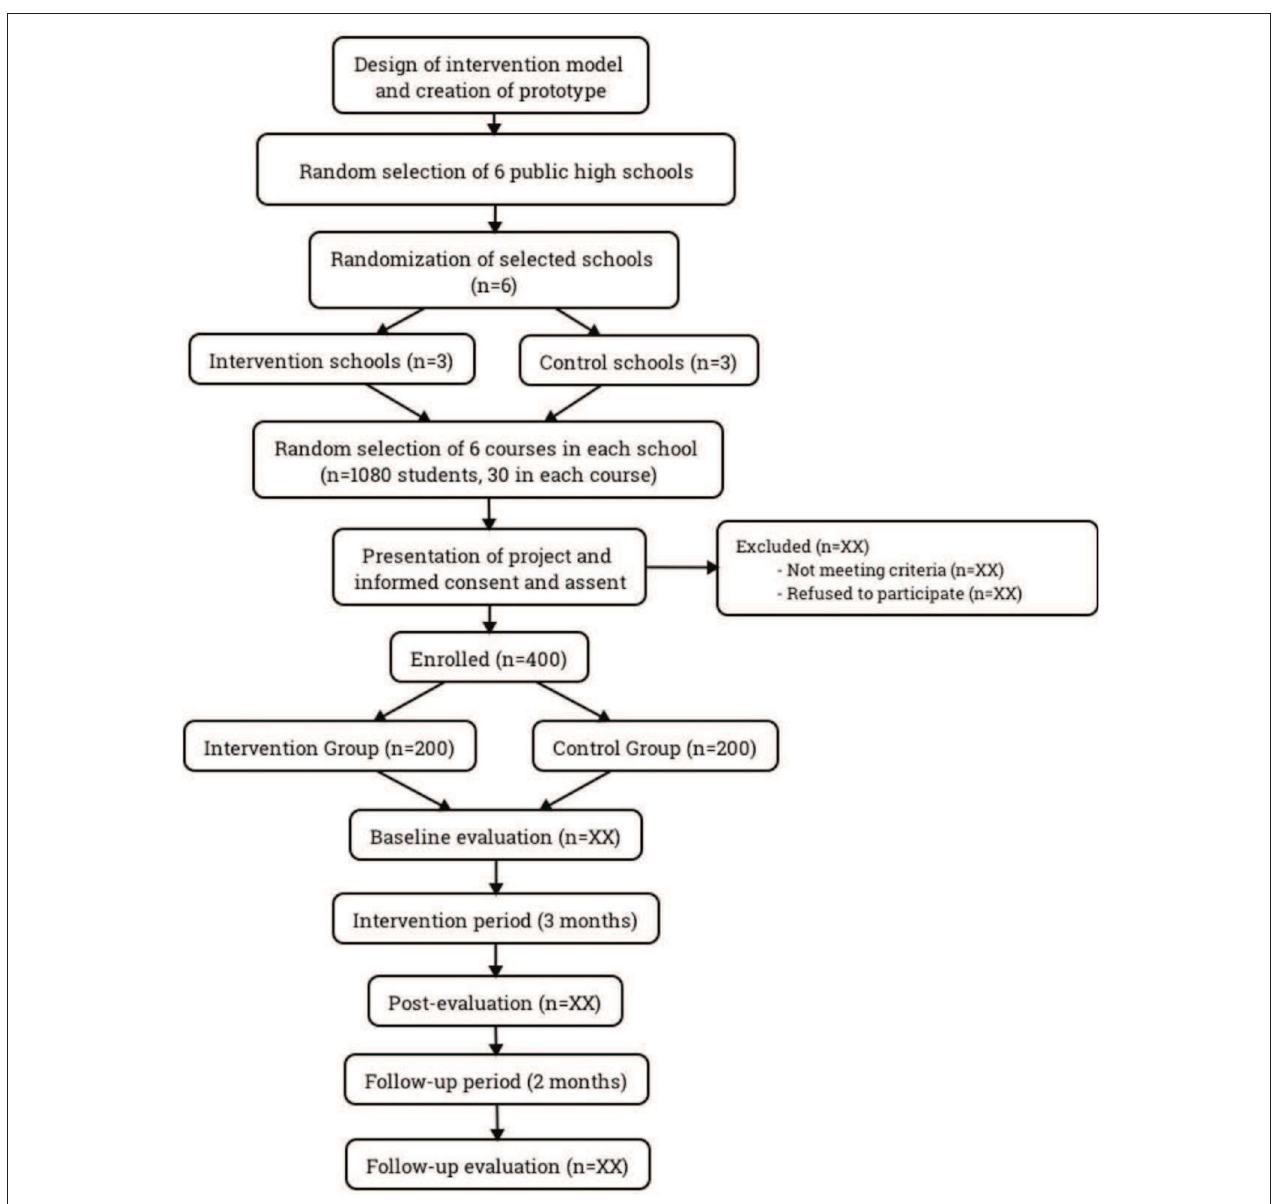
FIGURE 1 | Flowchart of the cluster